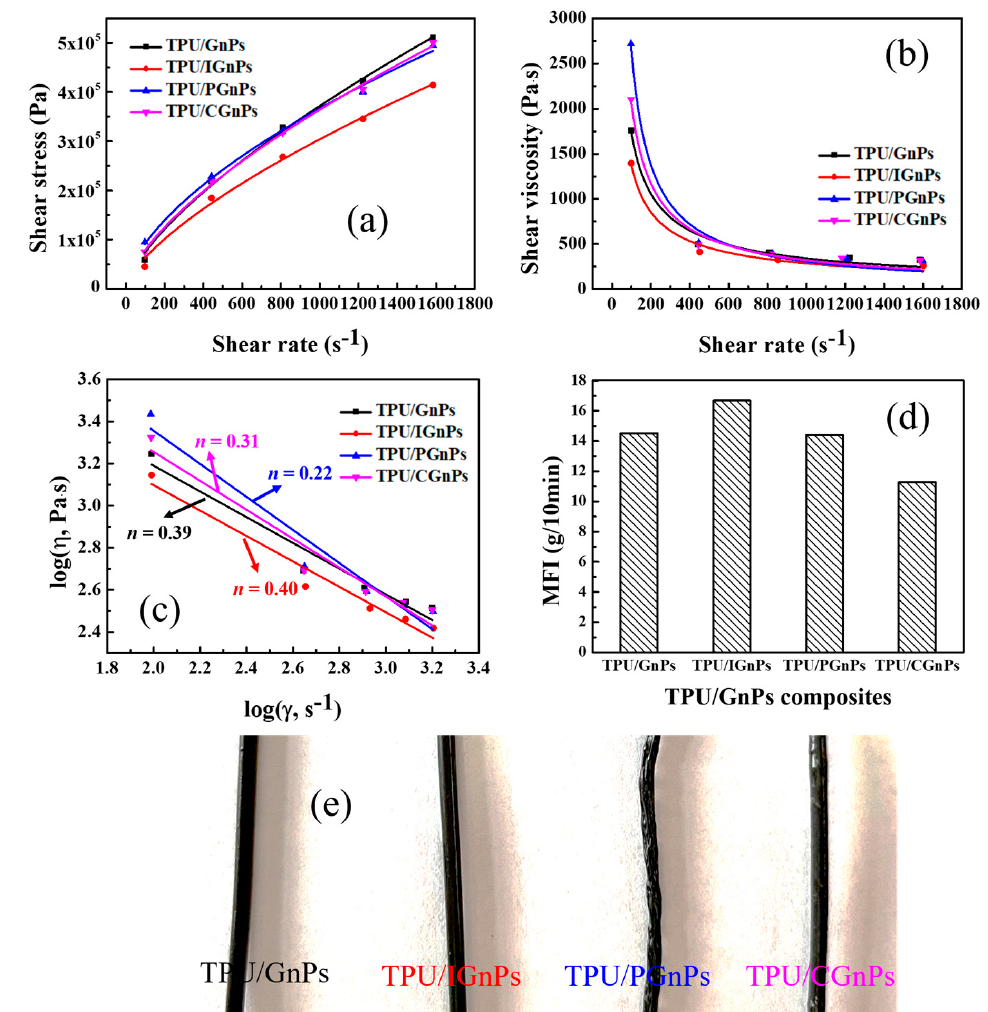
Figure 3. ( a ) Shear stress, ( b ) shear viscosity, ( c ) the bilogarithmic plots of viscosity versus shear rate, ( d ) MFI of various TPU/GnPs composites and ( e ) various TPU/GnPs-based filaments.